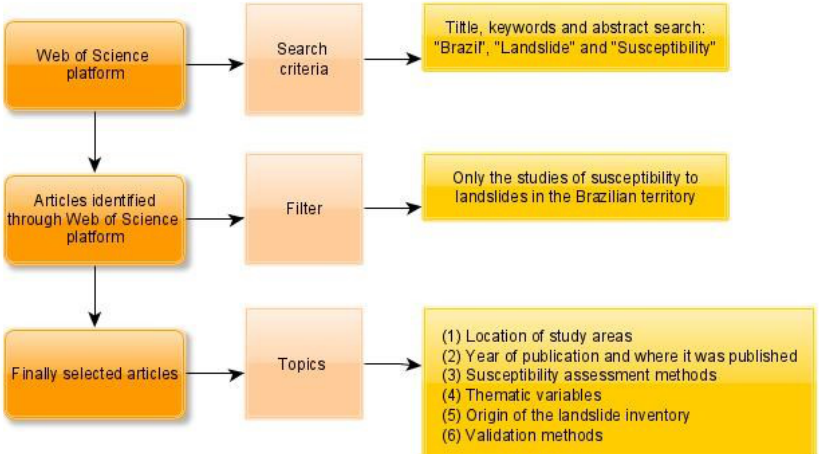
Figure 2. Systematic analysis procedure based on three main steps: search, filtering, and organization of the